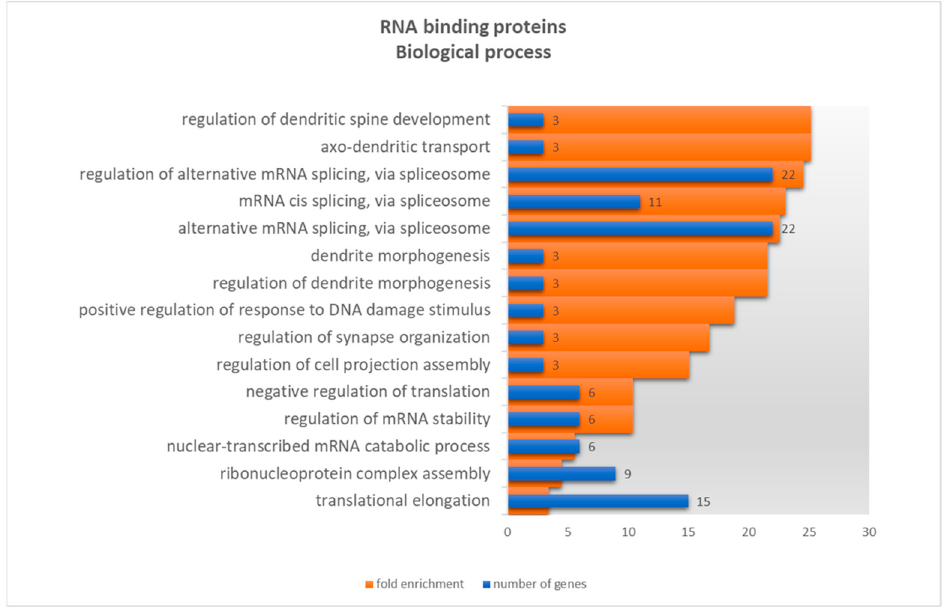
Figure 3. Gene ontology results for 122 potential NAPRT RNA binding proteins, based on biological processes annotation dataset, showing the number of genes (blue bars) and fold enrichment (orange bars) by decreasing fold enrichment order. Only child terms are presented. Detailed information on GO results can be found in Supplementary Table S7. The genes responsible for the highest enrichment fold were retrieved (FXR1, FXR2 and FMR1).